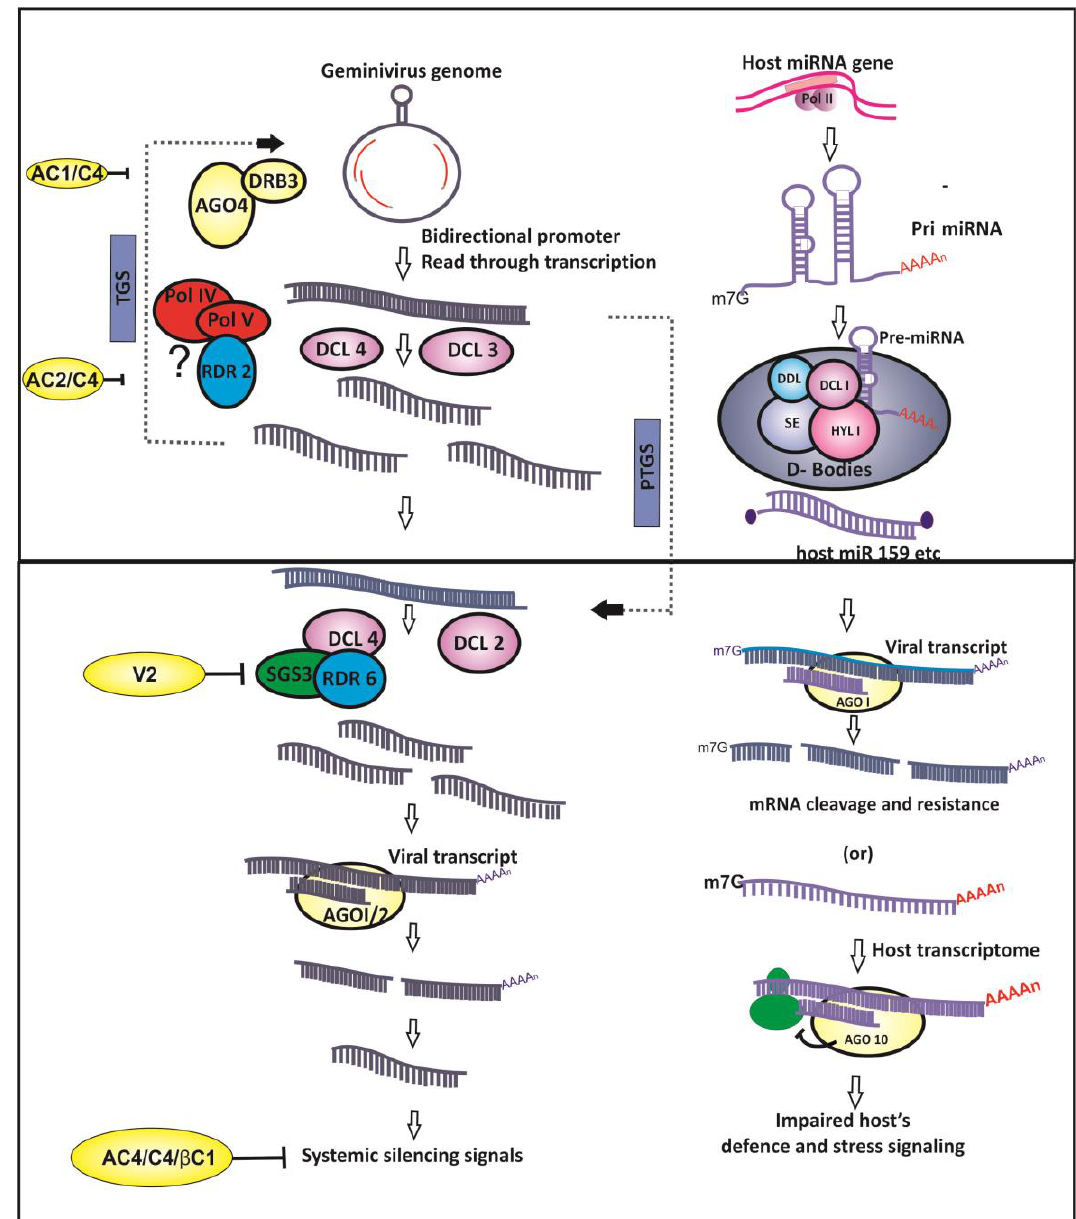
Figure 1. Geminivirus and host interactions at the small RNA interface. The host RNA silencing machinery targets viral transcripts via small interfering RNAs (siRNAs) generated from the viral genome and through host-derived microRNAs (miRNAs). Viral suppressors of RNA silencing (VSRs) counter host RNA silencing based defense, and impaired defense is also manifested due to interference in miRNA-mediated gene regulatory network.